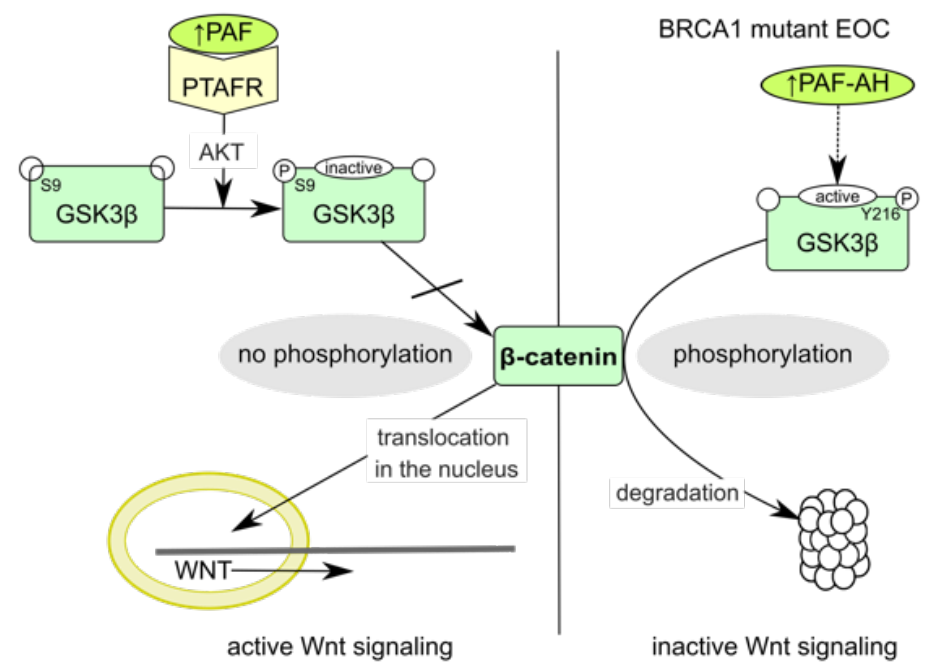
Figure 7. Activation states of canonical Wnt signaling pathway and possible regulation by PAF/PTAFR or PAF-AH. Inactivation of GSK3 β by phosphorylation at S9 either in the presence of Wnt ligands or following signal transduction through PAF/PTAFR/AKT (left) led to accumulation of non-phosphorylated β -catenin and translocation in the nucleus [40,53]. There, β -catenin displaces Groucho/TLE repressors from transcription factors Tcf/Lef and activates transcription of Wnt-responsive genes [54]. In the absence of Wnt ligands or PAF signaling, e.g., through enhanced PAF degradation by PAF-AH (right), β -catenin is marked by active GSK3 β for ubiquitination and proteasomal degradation [8,39].